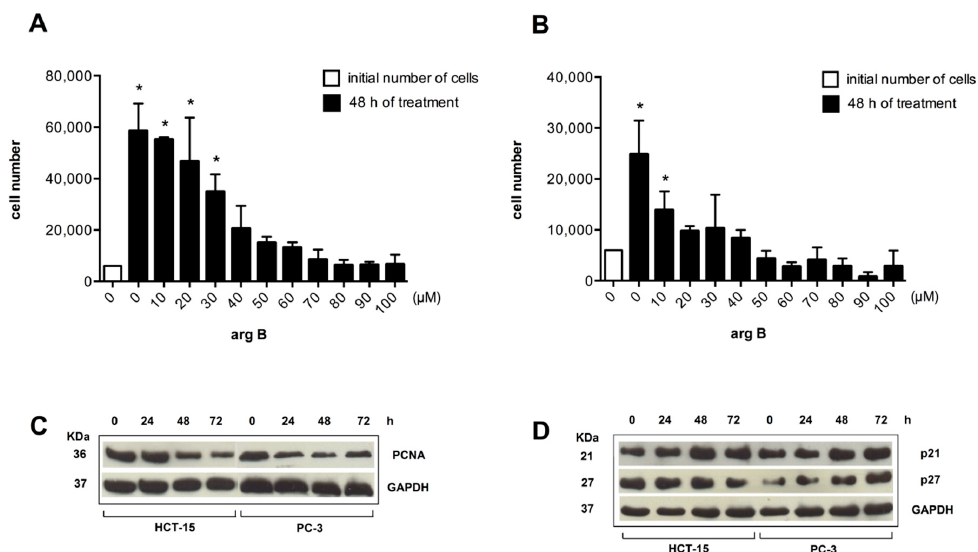
Figure 5. Argentatin B inhibits cell proliferation and increases expression of senescence-associated proteins. HCT-15 ( A ), and PC-3 ( B ) cells were treated with the indicated concentrations of argentatin B for 48 h. Cell numbers were evaluated by using the colorimetric MTT assay. Values presented are the mean of three independent experiments. Error bars indicate the standard error of the mean. * p < 0.05, vs. the number of cells seeded at the beginning of the experiment (initial number of cells) (one-way ANOVA test, and Tukey-Kramer post-test); ( C ) Western blot analysis of the expression of the proliferation marker PCNA. HCT-15, and PC-3 were incubated with 24 μ M or 34 μ M argentatin B, respectively for 24, 48, and 72 h. Detection of GAPDH was included as an internal control; ( D ) Western blot analysis of the expression of negative cell cycle regulators p21 and p27 in response to argentatin. HCT-15 and PC-3 cells were incubated with 24 µ M or 34 µ M argentatin B, respectively for 24, 48, and 72 h. Detection of GAPDH was included as an internal